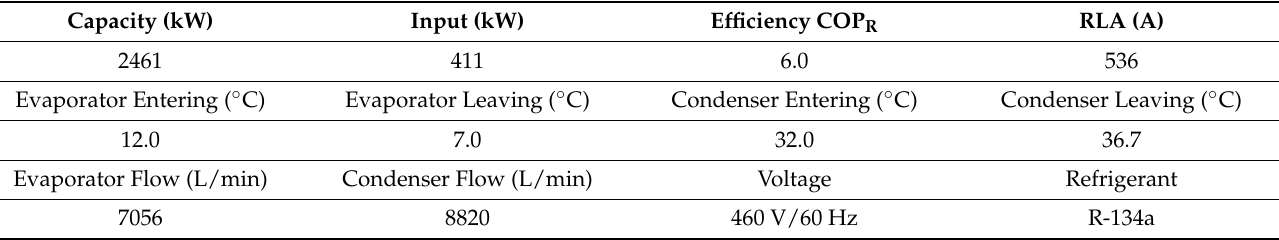
Table 4. List of the basic specifications of the actual water chiller.